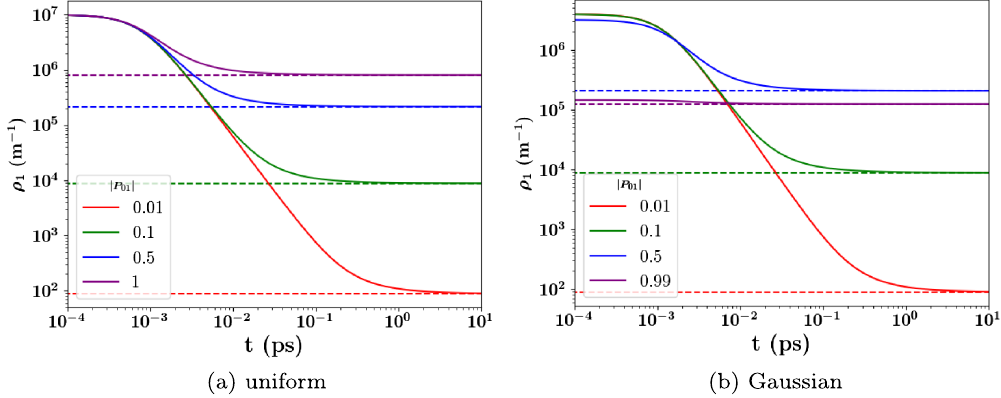
FIG. 2. Theoretical density evolution (solid lines) of specific distribution points in the free expansion of the bunch demonstrating the origin of the relativistic shock. The dotted lines indicate the asymptotic value determined by Eq. (39). The points correspond to locations that symmetrically contain approximately 1%, 10%, 50%, and either 100% (uniform) or 99% (Gaussian) of the distribution as indicated by their P 01 value. The timescales of all points inversely correlate with their location in the distribution [see Eq. (36)]. For the uniform distribution (a), all points start at the same density but converge to different asymptotes according to the inverse relationship between position and timescale. This leads to a parabolic distribution as seen in Eq. (40) as L 0 ≪ l here. For the Gaussian distribution (b), the r 01 fact that the outer points have lower initial densities leads to density trajectories crossing indicating the formation of the density peak that goes both up and down in contrast to the sharp peak seen in the uniform